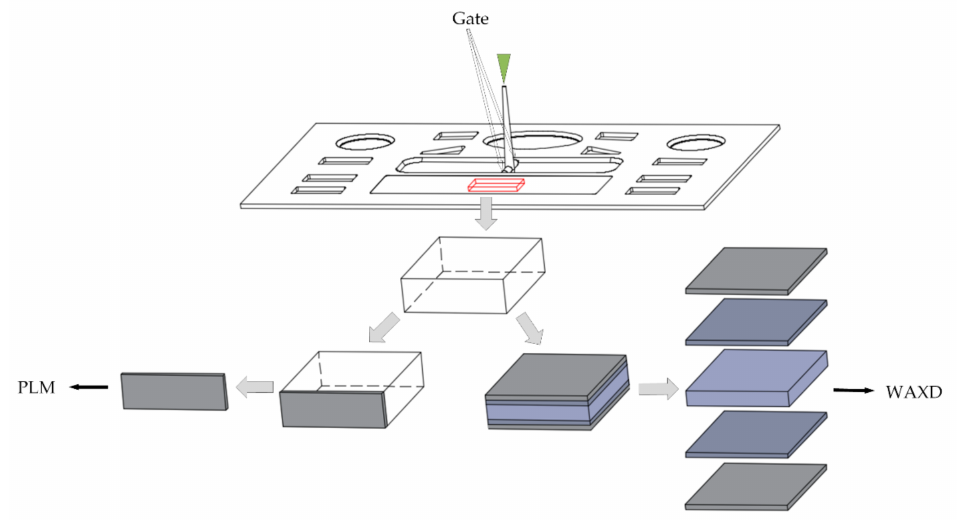
Figure 3. Experimental